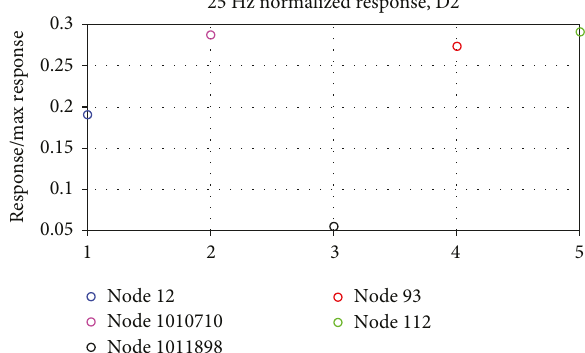
Figure 20: D2, 30Hz normalized responses, double excitation tests.